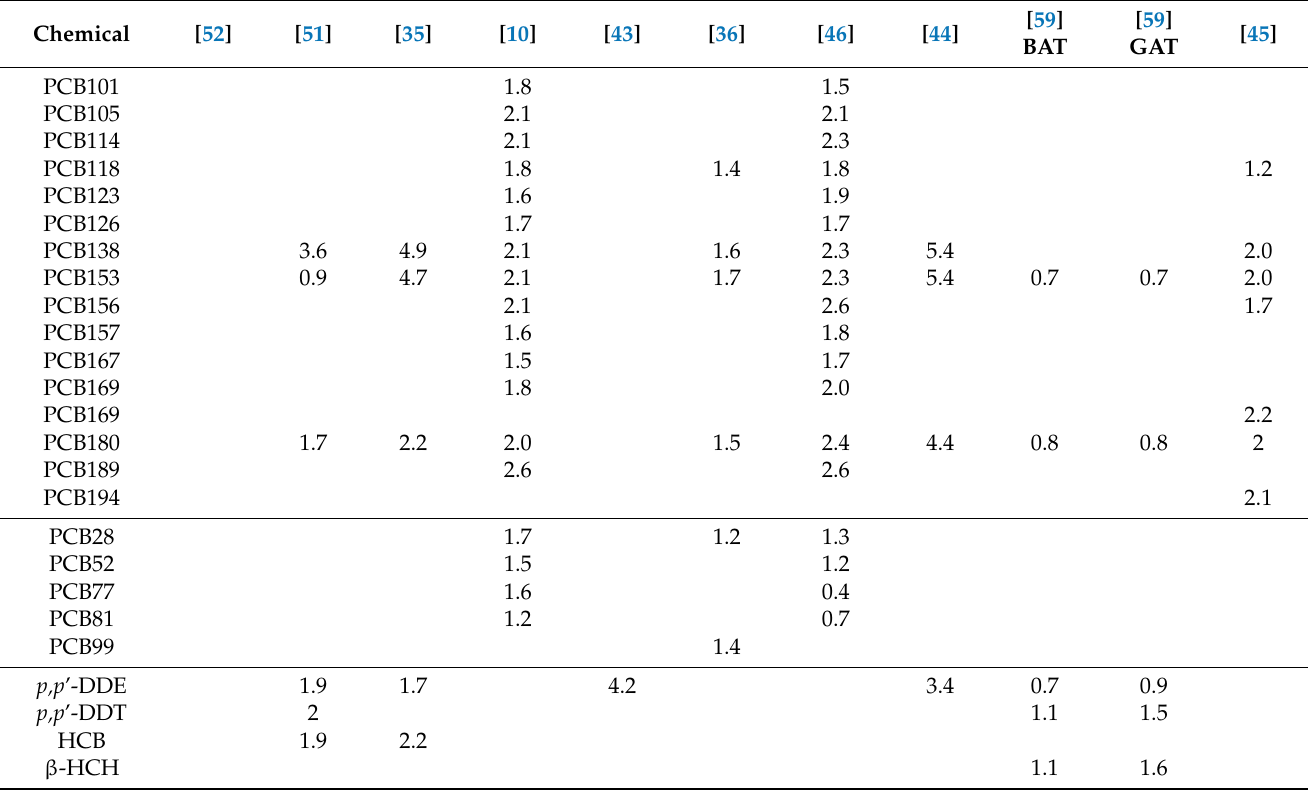
Table 4. Congener-specific summary of mean coefficient partitions of persistent organic pollutants between adipose tissue and serum, both normalized on the lipid weight